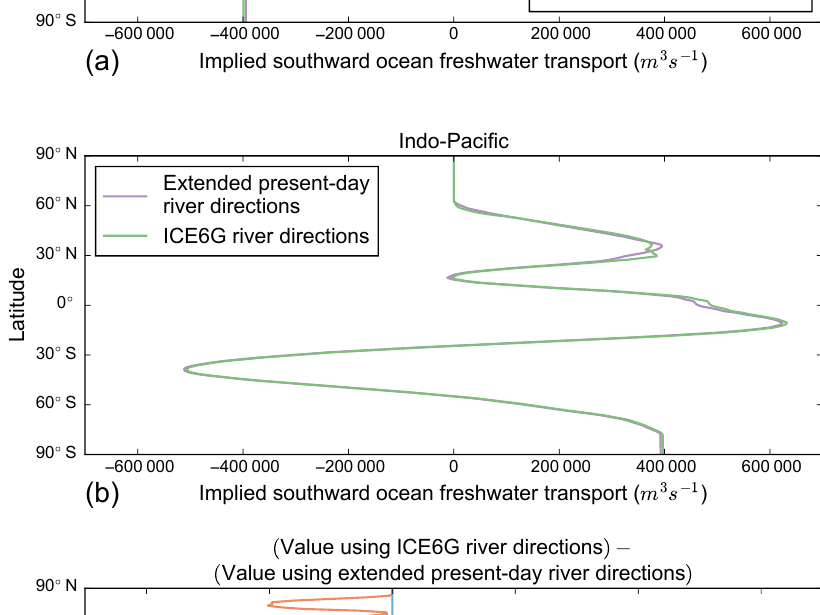
tions (Hostetler et al., 2000; Krinner et al., 2004) and pre- cludes both the inclusion of the mass of the water in the lakes as a feedback to the viscoelastic Earth model and the mod- elling of lacustrine calving of ice sheets where they are in direct contact with an adjacent